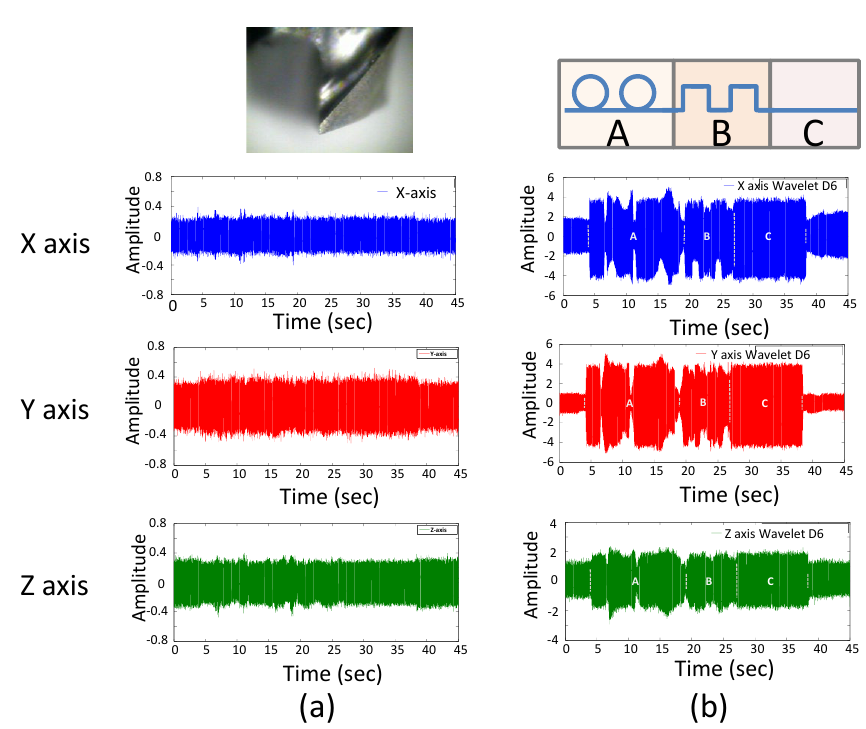
Figure 6. Time domain vibration signal with a new tool: ( a ) raw signal; ( b ) wavelet coefficient (sharp tool).